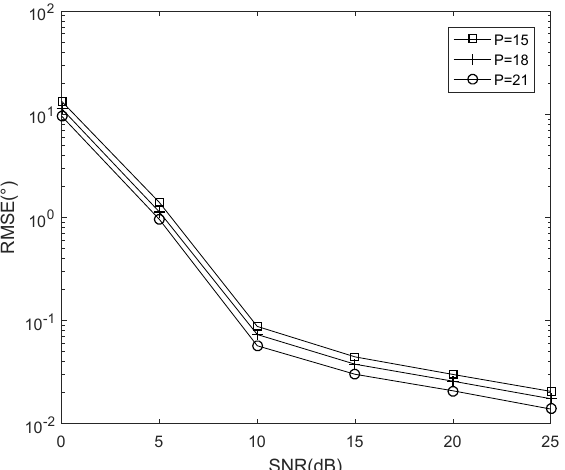
Figure 10. RMSE performance of θ versus SNR.